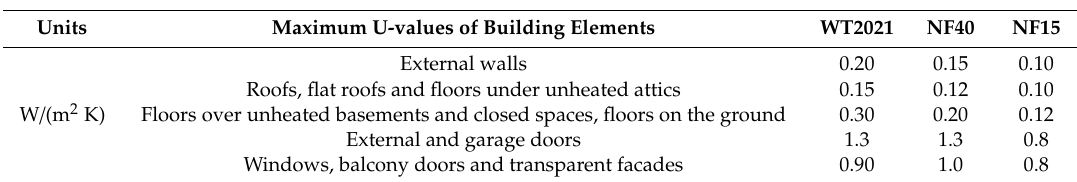
Table 3. Heat transfer coe ffi cient (U-value) requirements for the WT2021, NF40 and NF15 standards [3,19].